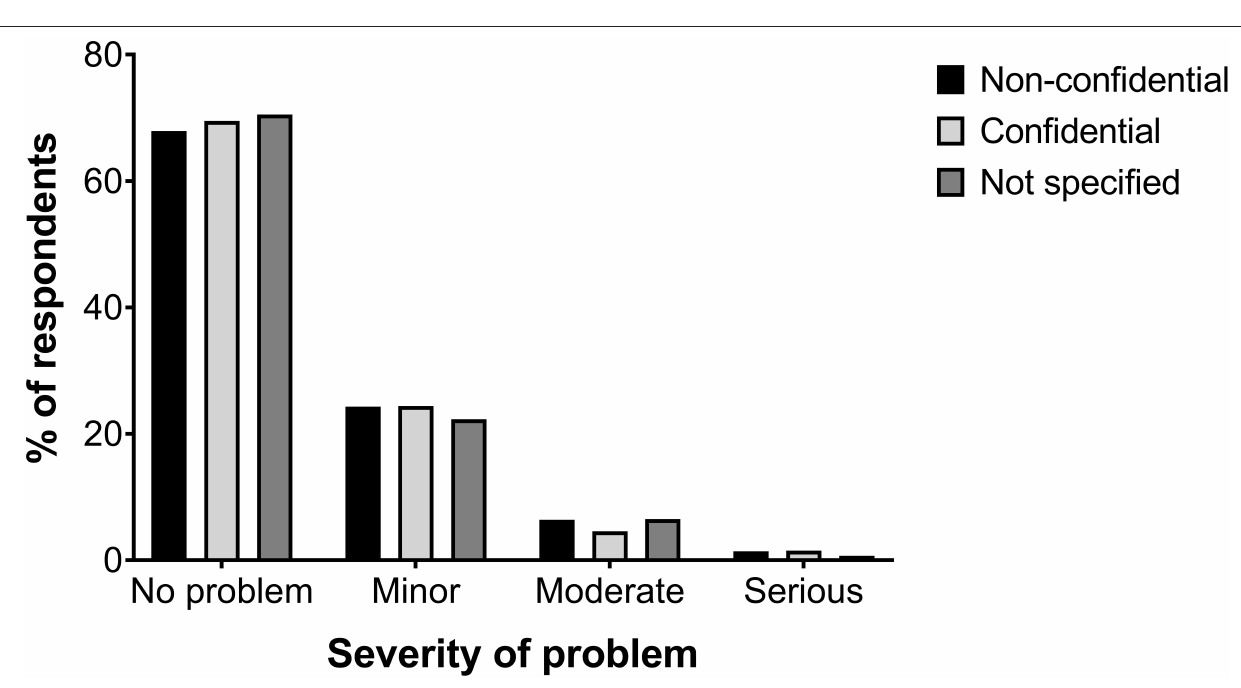
scores are highly correlated with those of the standard, 100- item C-BARQ (20) which has been used extensively in the literature (26,